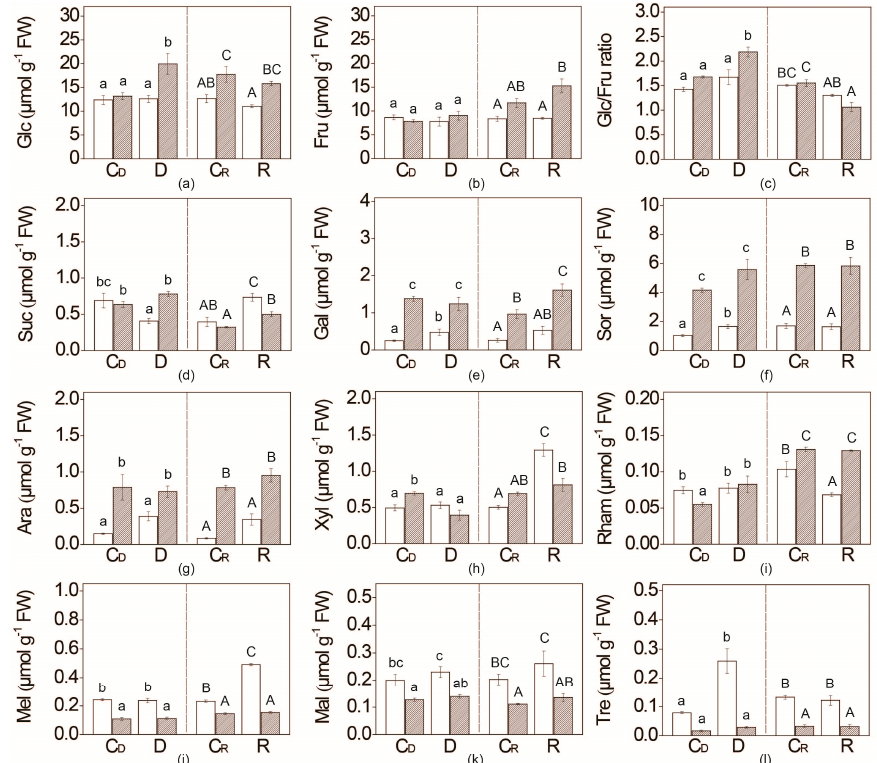
Figure 3. Content of soluble sugars: ( a ) glucose—Glc; ( b ) fructose—Fru; ( c ) Glc/Fru ratio; ( d ) sucrose—Suc; ( e ) galactose—Gal; ( f ) sorbitol—Sor; ( g ) arabinose—Ara; ( h ) xylose—Xyl; ( i ) rhamnose—Rham; ( j ) melibiose—Mel; ( k ) maltose—Mal; ( l ) trehalose—Tre; in the leaves of WT (white bars) and flacca (patterned bars) tomato genotypes subjected to six day water deficit (D) period followed by a six day period of re-watering (R). Respective controls corresponding to water-deficit condition (C D ) and re-watering (C R ) are presented. Values are presented as means ± SE ( n = 4). Different letters denote significant differences between means according to Tukey HSD post hoc test p ≤ 0.05. Small letters represent the differences in means of drought treatment, while capital letters represent re-watering treatment.